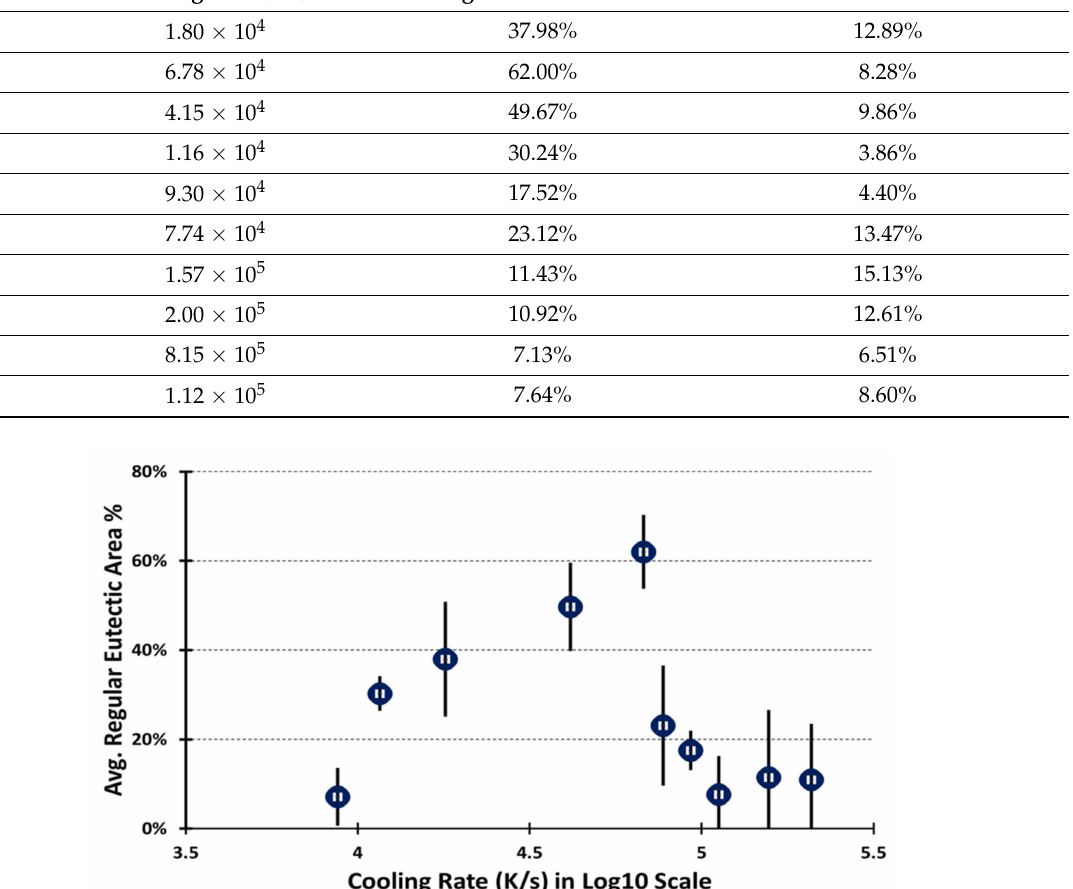
Figure 10. Cooling rates and fully eutectic area percentages relative to the total melt pool area. Errors are represented with one standard